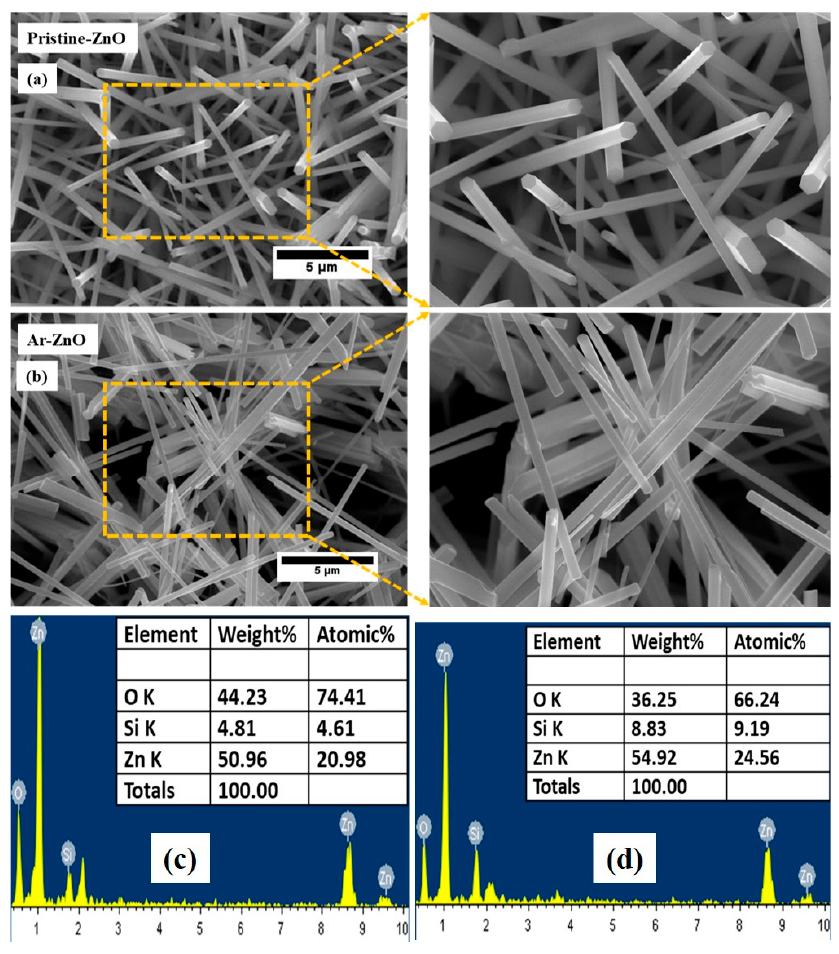
Figure 3. ( a , b ) The FESEM images of pristine ZnO and Ar-ZnO nanowires, respectively, along with the enlarged view of one portion of the images, ( c , d ) EDX spectra of pristine ZnO and Ar-ZnO nanowires.